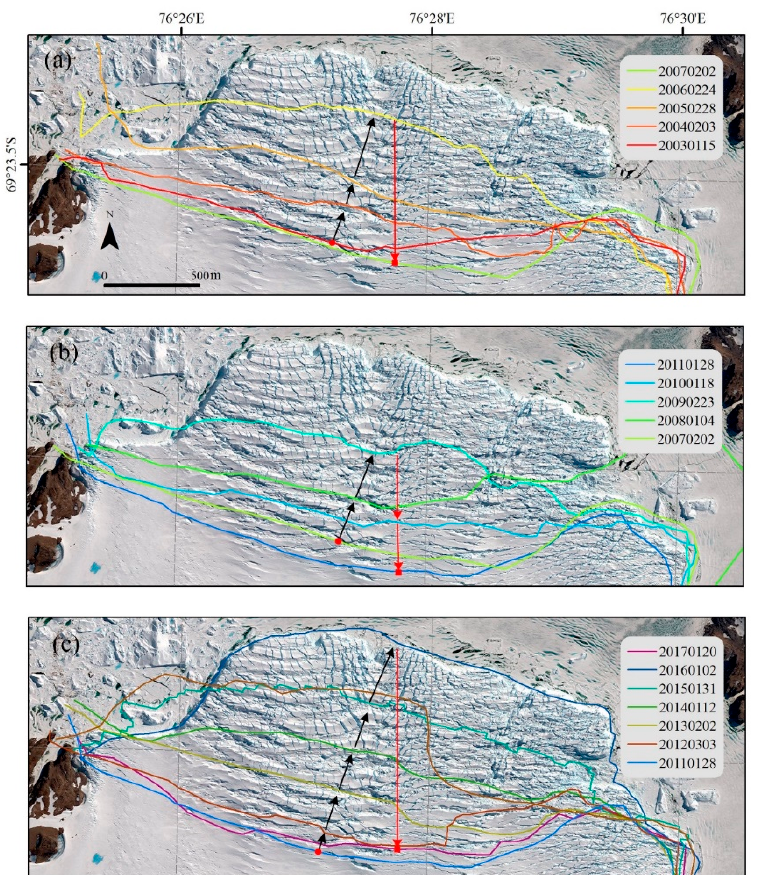
Figure 2. Three advance and retreat stages of Dalk Glacier during 2003–2017. The background is the Worldview-2 image acquired on 2 January 2016. The black arrows represent the glacier advance, while the red arrows represent the terminus retreat.